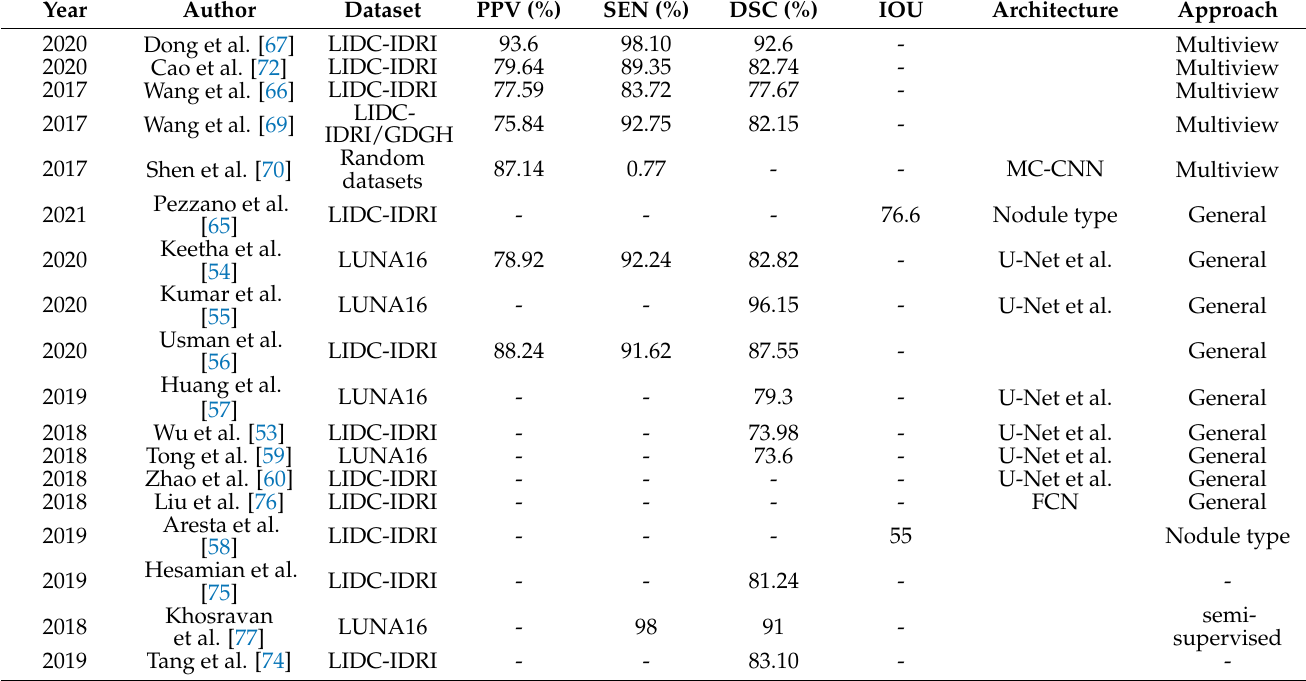
Table 5. Results comparison of nodule segmentation